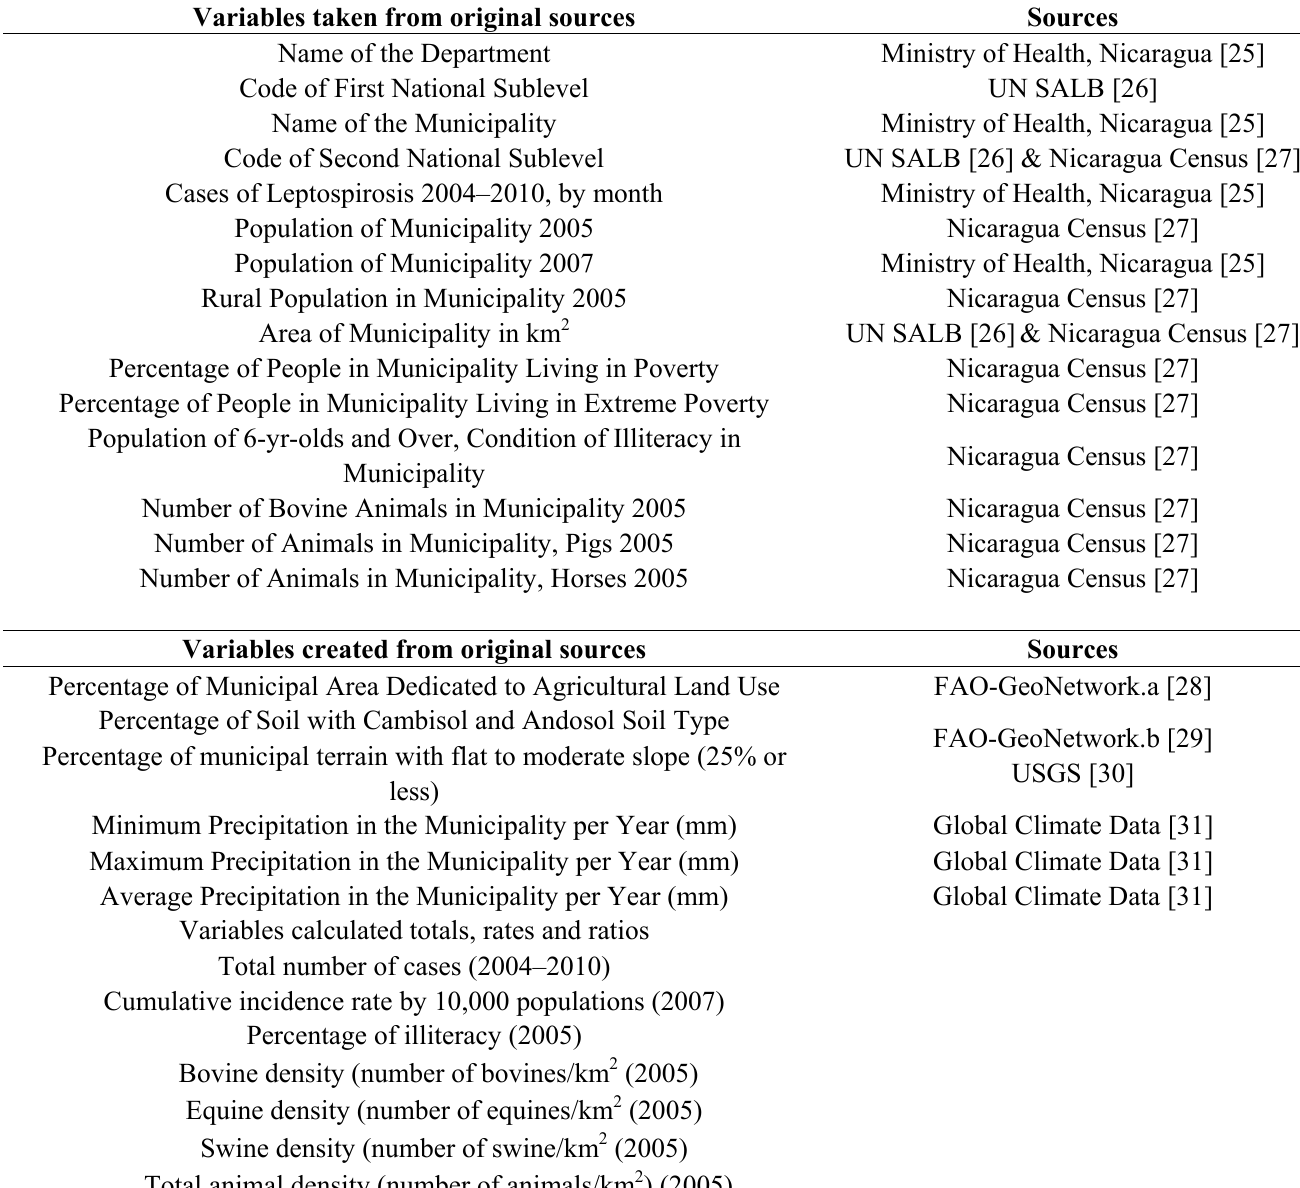
Table 1. Selected variables and sources of information used to create a database by